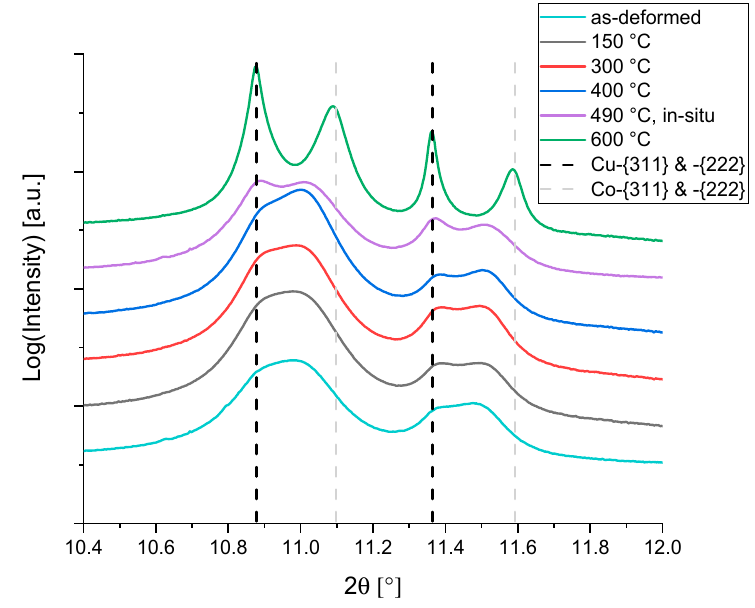
Figure 5. HEXRD pattern of the as-deformed and ex-situ and in-situ annealed Cu 55 Co 45 specimens, in addition the lines of pure elements are shown.